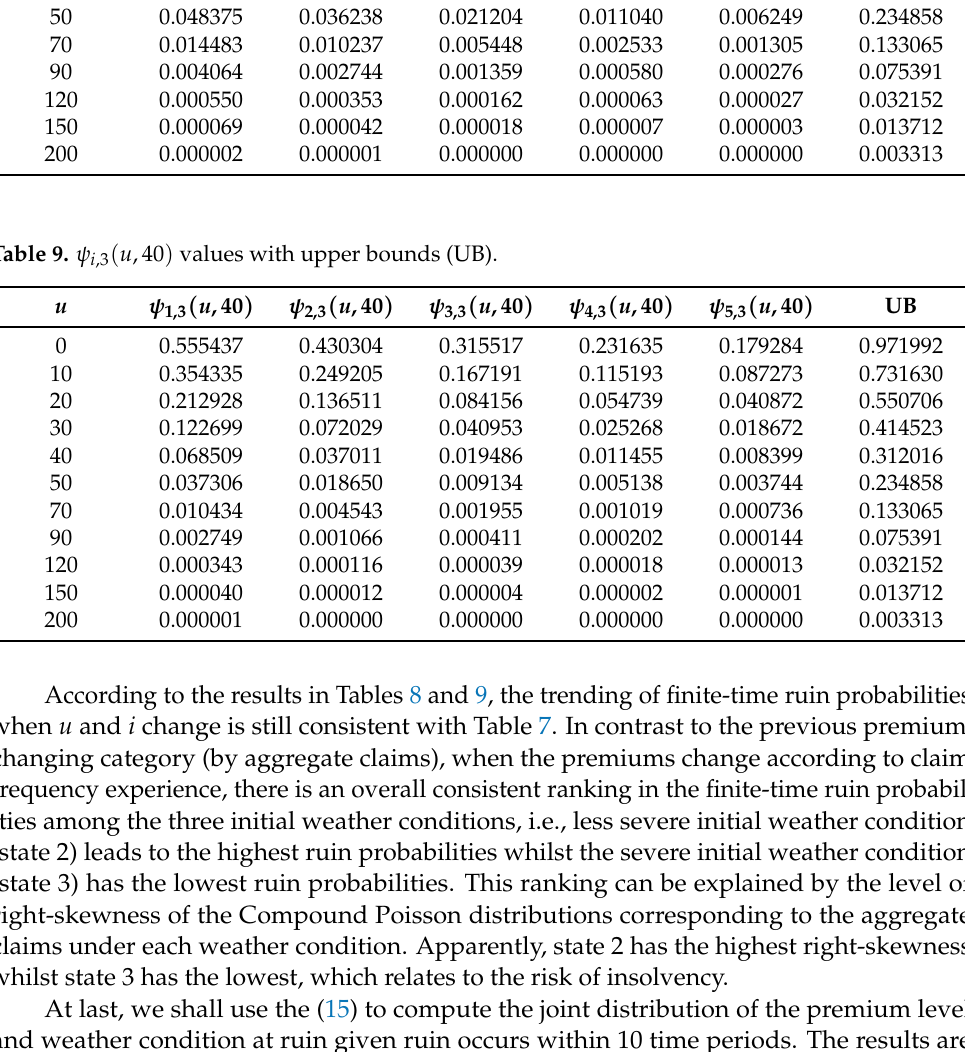
Table 10. Results for χ (cid:48)